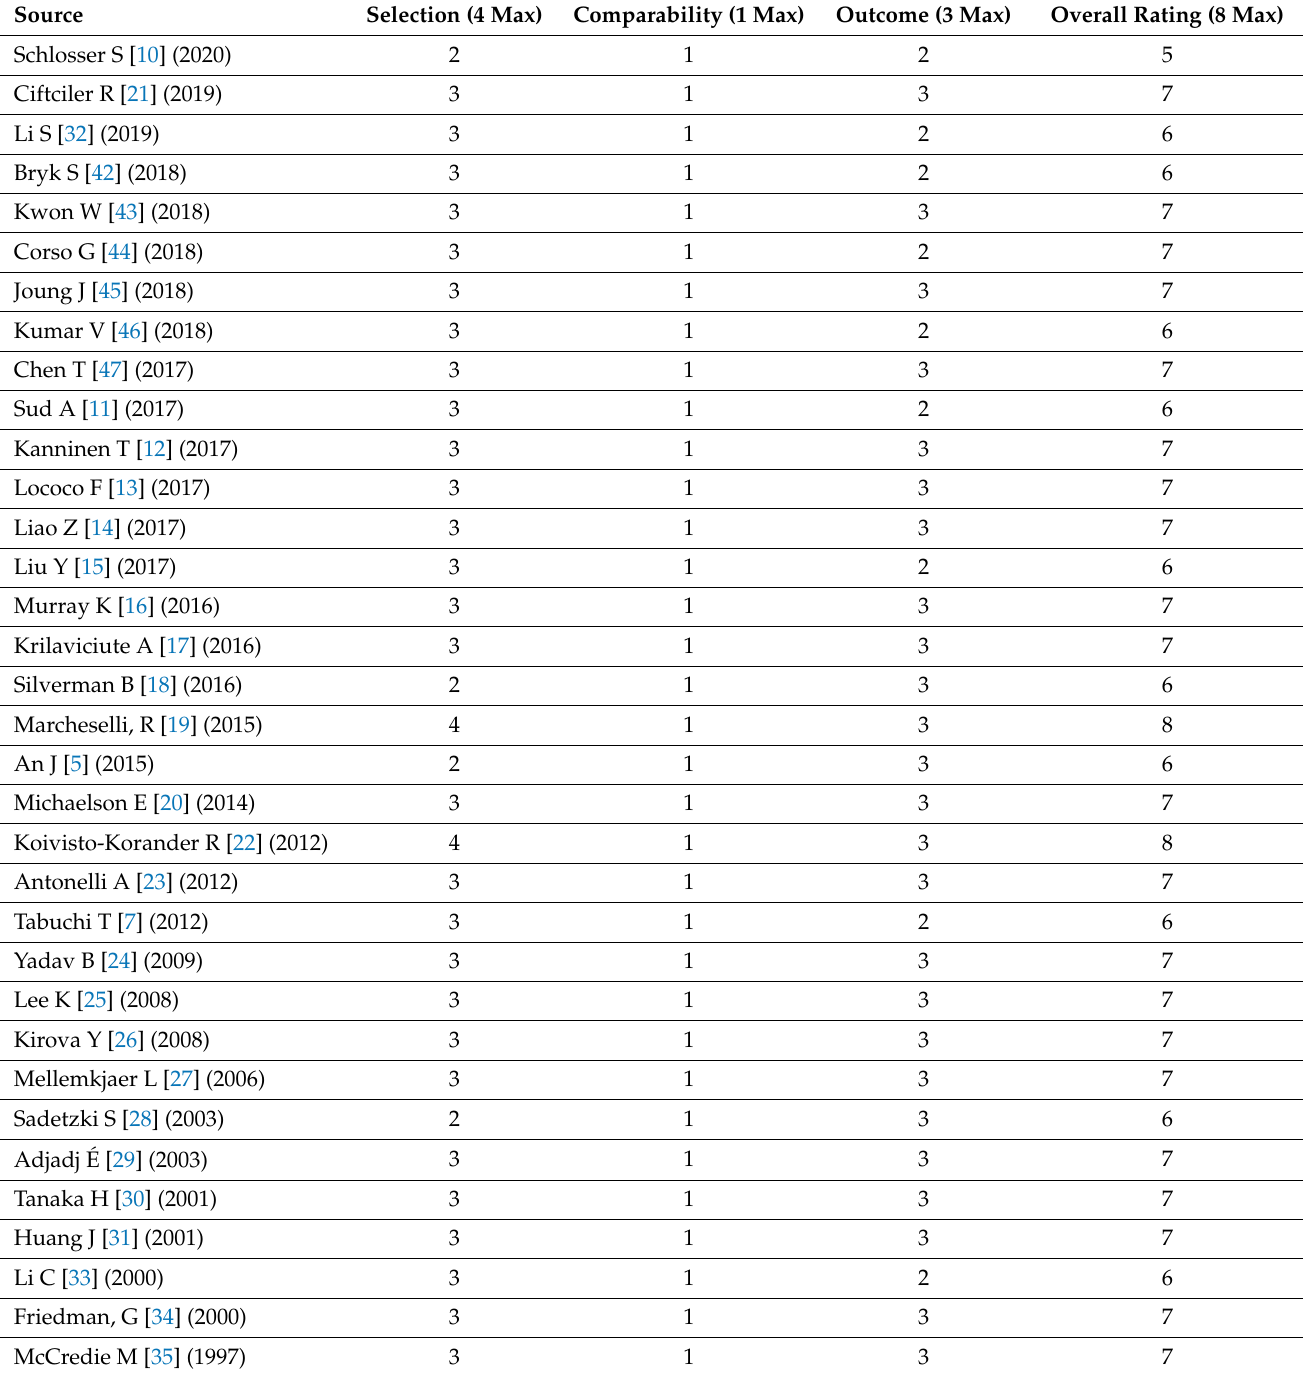
Table 2. Quality index scoring based on Newcastle–Ottawa Scale